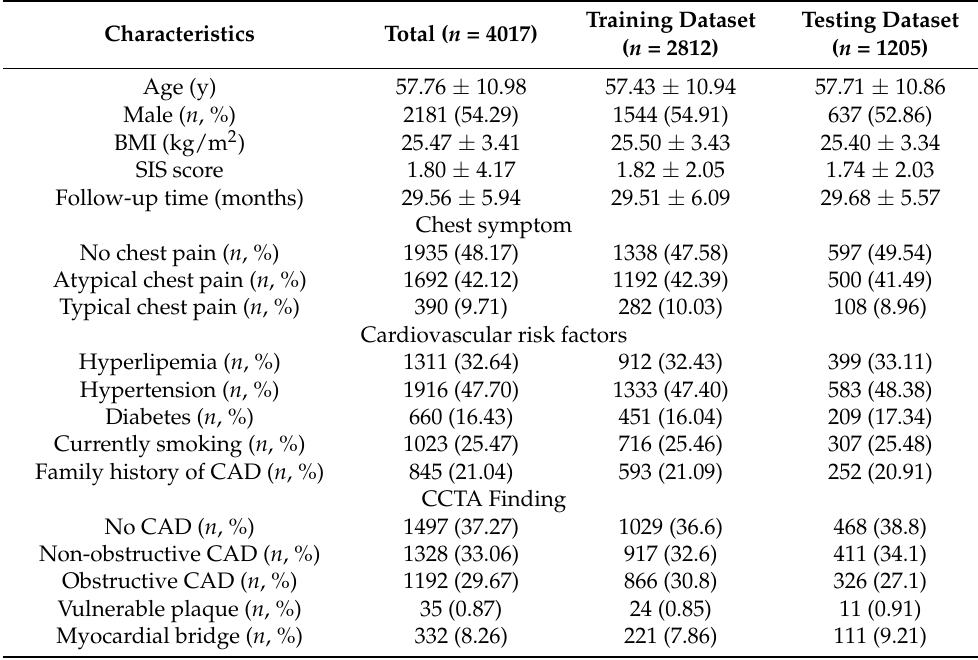
Table 2. Demographic and Clinical Characteristics of Patients at